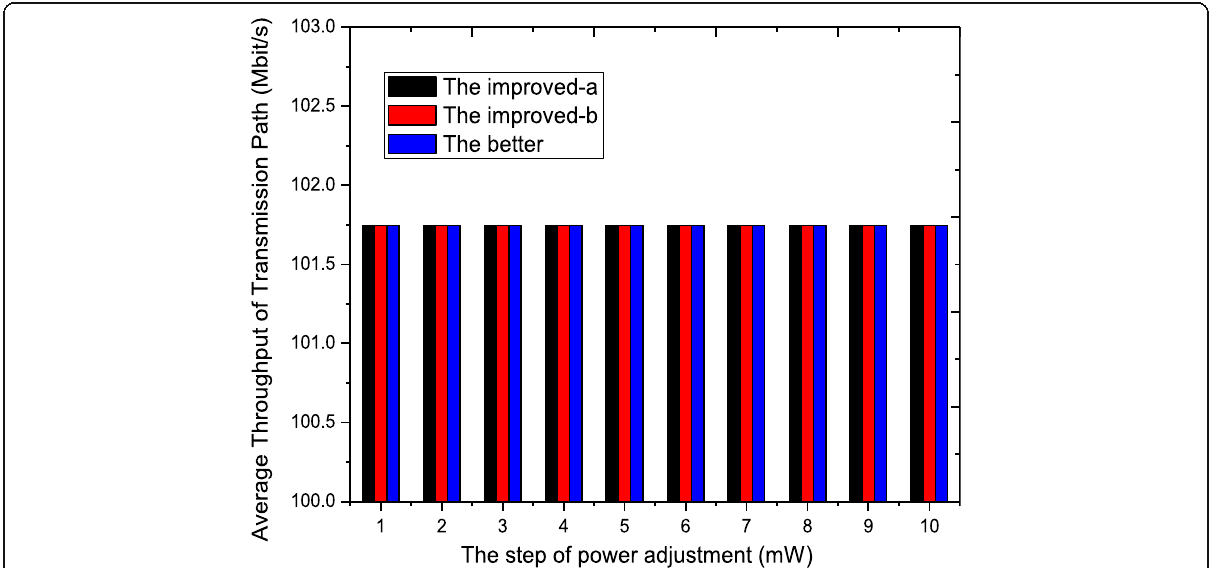
Fig. 14 Throughput performance comparison: variation trend of throughput of TOM-PAOD with the step size for power adjustment, in which the different game decision algorithms are adopted